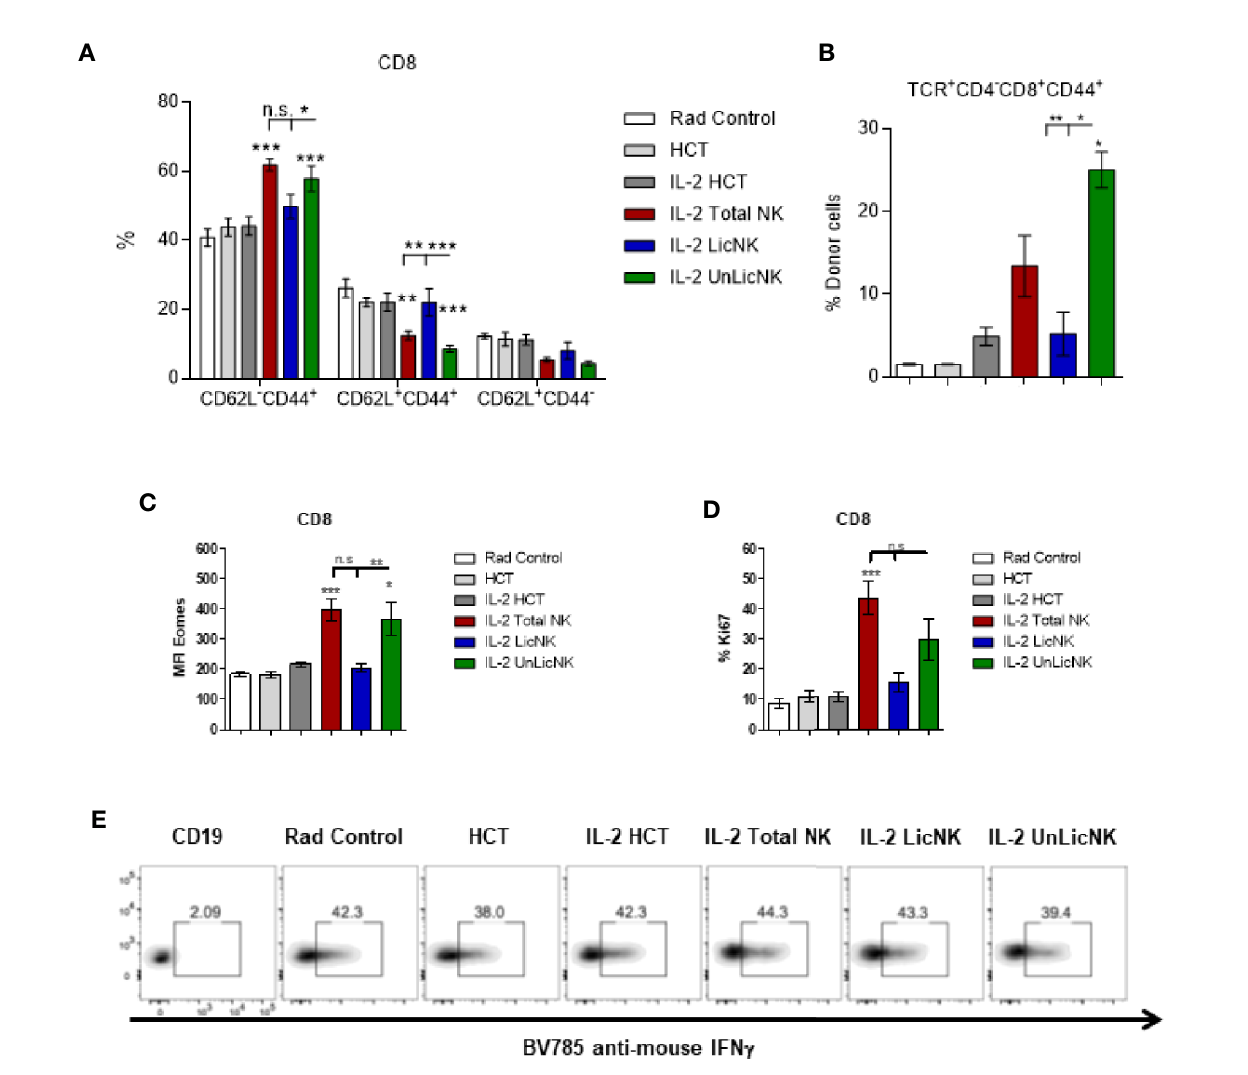
FIGURE 3 | The treatment with UnLicNK cells causes an increase of donor-derived effector-memory CD8 T cells. Splenocytes were collected at day 28 post-HCT andphenotypicanalysiswas performedby fl ow cytometry. (A) Percentage ofeffector memory(CD62L - CD44 + ),central memory(CD62L + CD44 + ), andnaïve (CD62L + CD44 - ) cellsubsets for CD3 + CD8 + T cells isshown. (B) Percentage of H2Dd + cells within the CD8 T effectormemory subset isshown. (C) MFI expression of the activating transcription factoreomes isshown for total (H2b/d) CD3 + CD8 + T cells. (D) Percentage of Ki67 for gatedtotal CD8T cells isshown. (E) Representativedot-plots ofIFN g + cells ongated total CD8T cellsafter stimulation with PMA/Io. Datais representative of two independent experiments with n=3 – 5 per group (mean ± SEM). One-way ANOVA or Two-Way ANOVA was used to assess signi fi cance (*p<0.05, **p<0.01, ***p<0.001, n.s, no signi fi